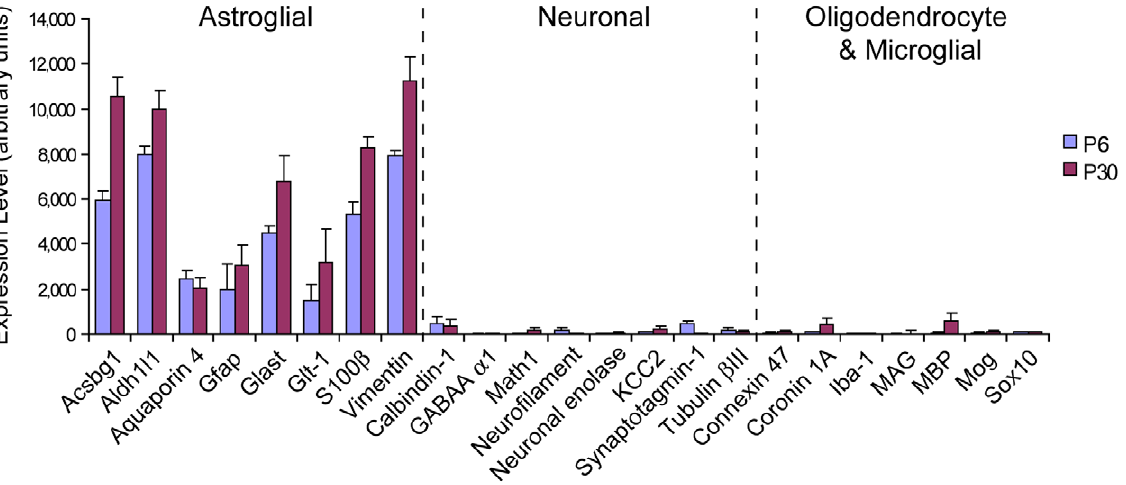
Figure 2. Expression profiles of cell type control genes confirm purity of Bergmann glial cDNA generated by single cell RT-PCR. Mean expression levels of well established markers for astroglia, neurons, oligodendrocytes and microglia were analyzed in the transcriptional profiles of ten Bergmann glia (five each from P6 and P30) using GeneSpring GX 7.3 software. For genes represented by multiple probe sets, the averaged expression of all probe sets were used. Astroglial genes were robustly expressed whereas markers of other cell types were absent or extremely low, confirming the astroglial identity of Bergmann glia and the absence of contaminating mRNAs from other cell types during cell harvesting. Error bars represent 6